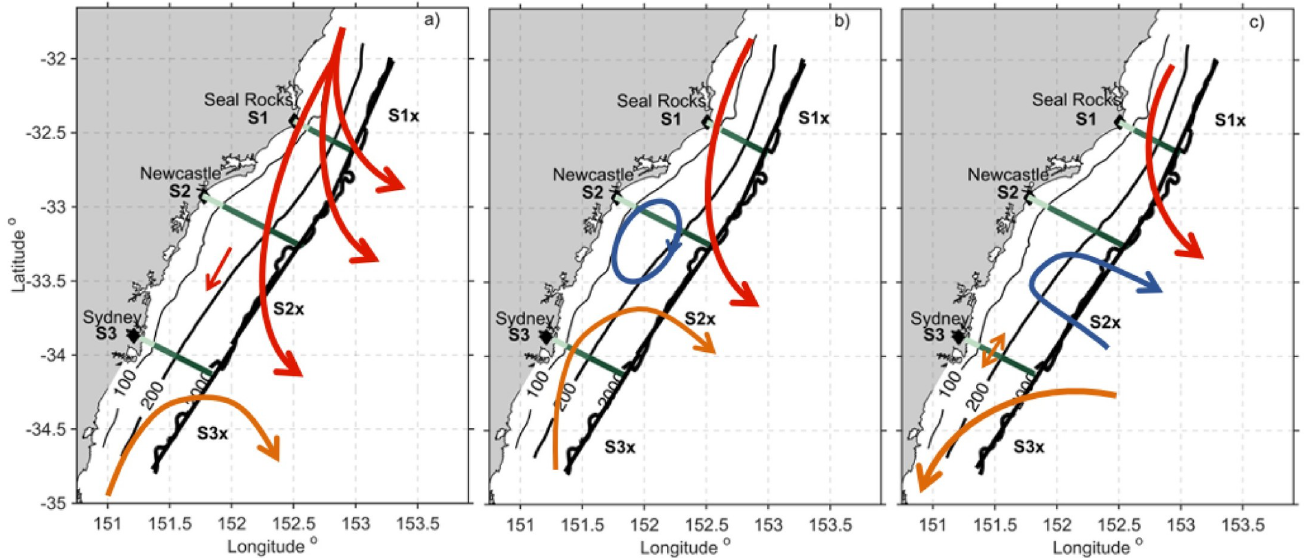
Fig 12. Schematic diagram representing the three main circulation patterns over the 2-yr period. (a) Scenario 1, occurring ~ 30% of the time, primarily in summer and autumn, b) Scenario 2 occurring ~20% of the time primarily in summer and autumn and c) Scenario 3 occurring ~ 11% of the time, primarily in winter and